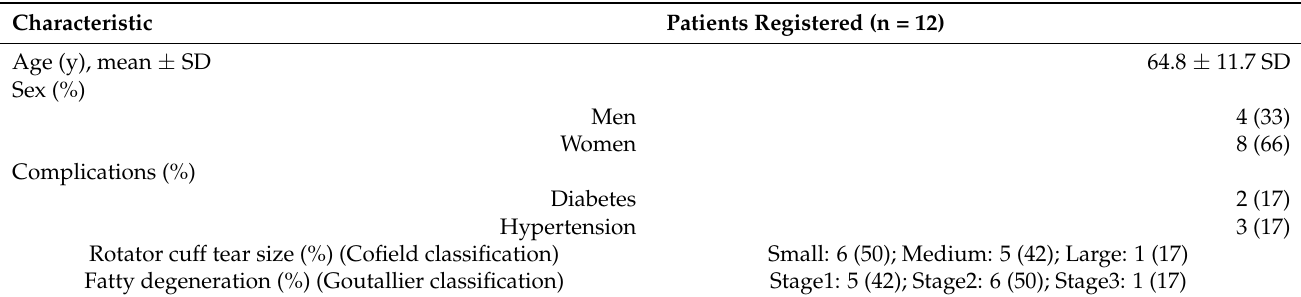
Table 1. Patient background characteristics.